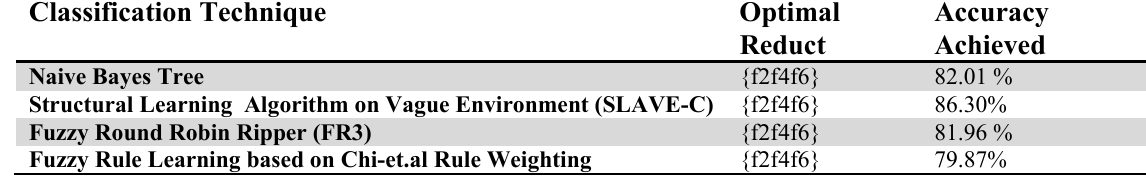
Optimal reduct - classifier prediction accuracy Classification Technique